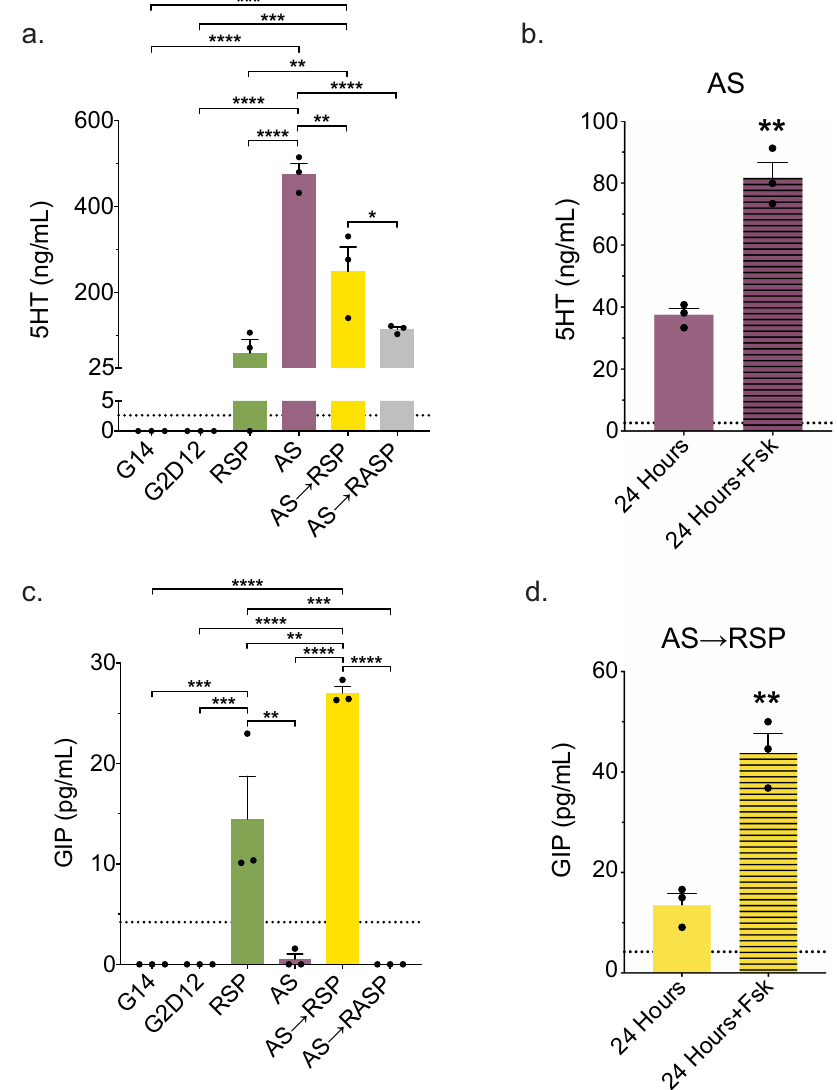
Fig. 7 Differentiation Conditions Induce Hormone Secretion. a Serotonin (5HT) ELISA of conditioned media from the last two days of differentiation of enteroids grown in G14, G2D12, RSP, AS, AS → RSP, and AS → RASP. Representative experiment showing n = 3 wells from each condition from a single enteroid line. * p = 0.049; ** p = 0.0049 (RSP to AS → RSP), 0.0011 (AS to AS → RSP); *** p = 0.0005 (G14 to AS → RSP and G2D12 to AS →